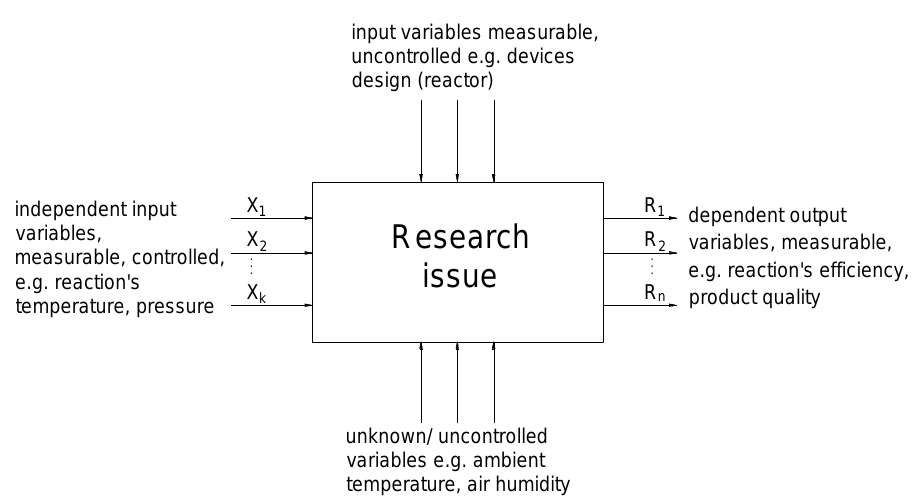
Figure 1. “Black–box” model of the research issue in design of experiments Figure 1. “ Black –box” model of the research issue in design of experiments methodology.